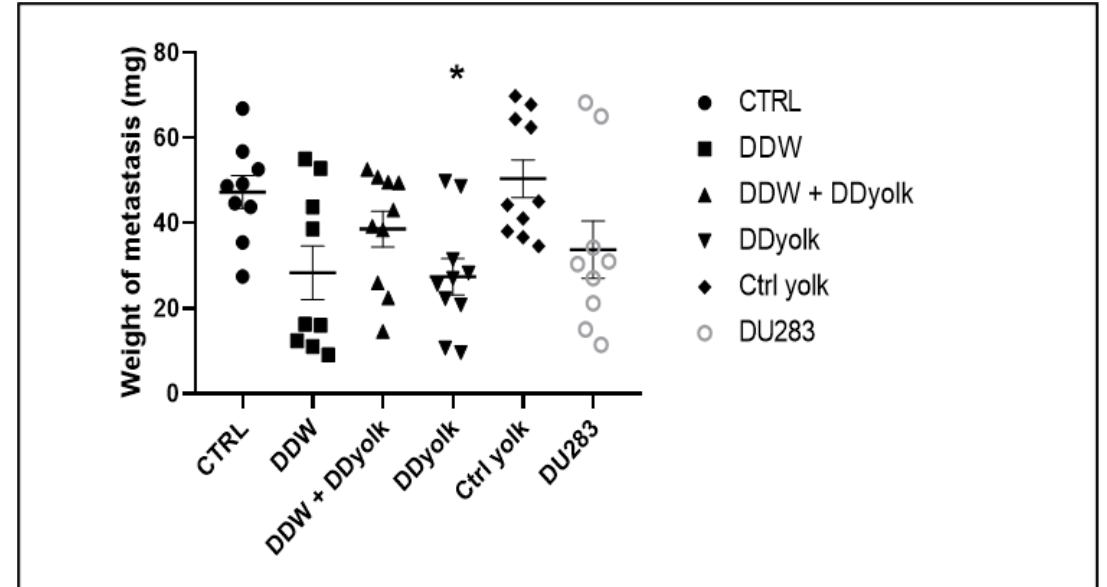
Figure 3. Weight of the metastases in the four treated and two control groups. The average weight of the metastases was lower in all four treated groups but only the group receiving deuterium-depleted yolk ( * ) showed significant differences (p = 0.0354) compared to the group consuming normal water and normal food. Dots represent individual data while the horizontal line with error bar shows mean and SD.